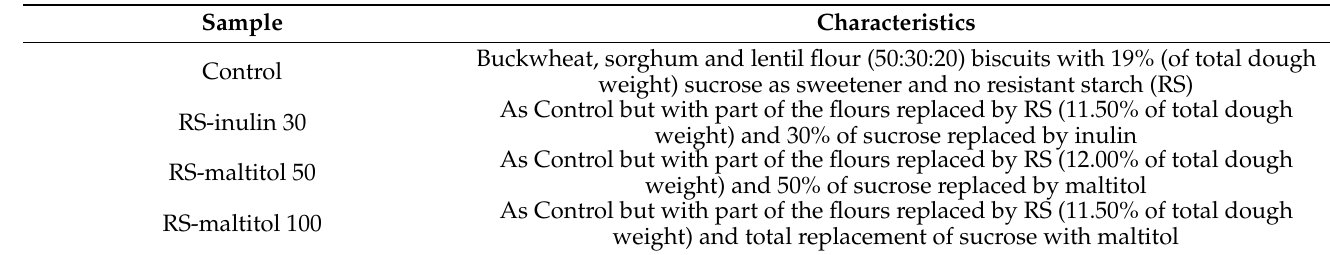
Table 2. Gluten-free biscuit samples and their main characteristics.